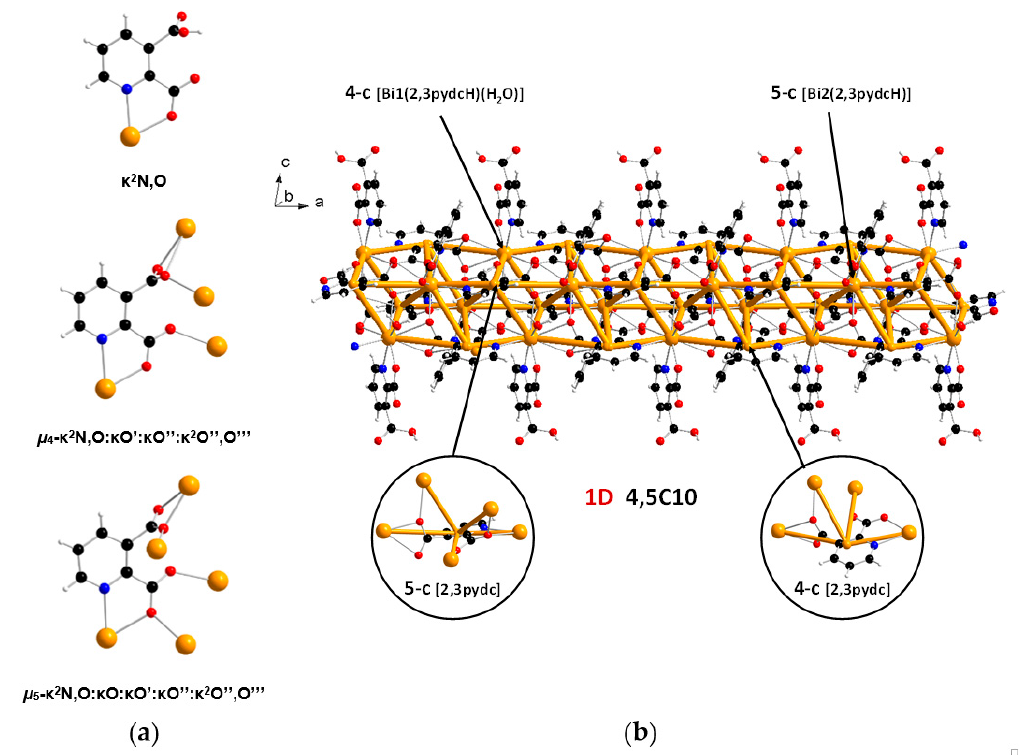
Figure 3. ( a ) Coordination modes of carboxylate ligands in complex 1 ; ( b ) a fragment of the 1D crystal structure merged with 4,5C10 underlying net in valence-bonded MOFs standard representation for coordination polymer 1 (Bi—orange, O—red, N—blue, C—black, H—white).